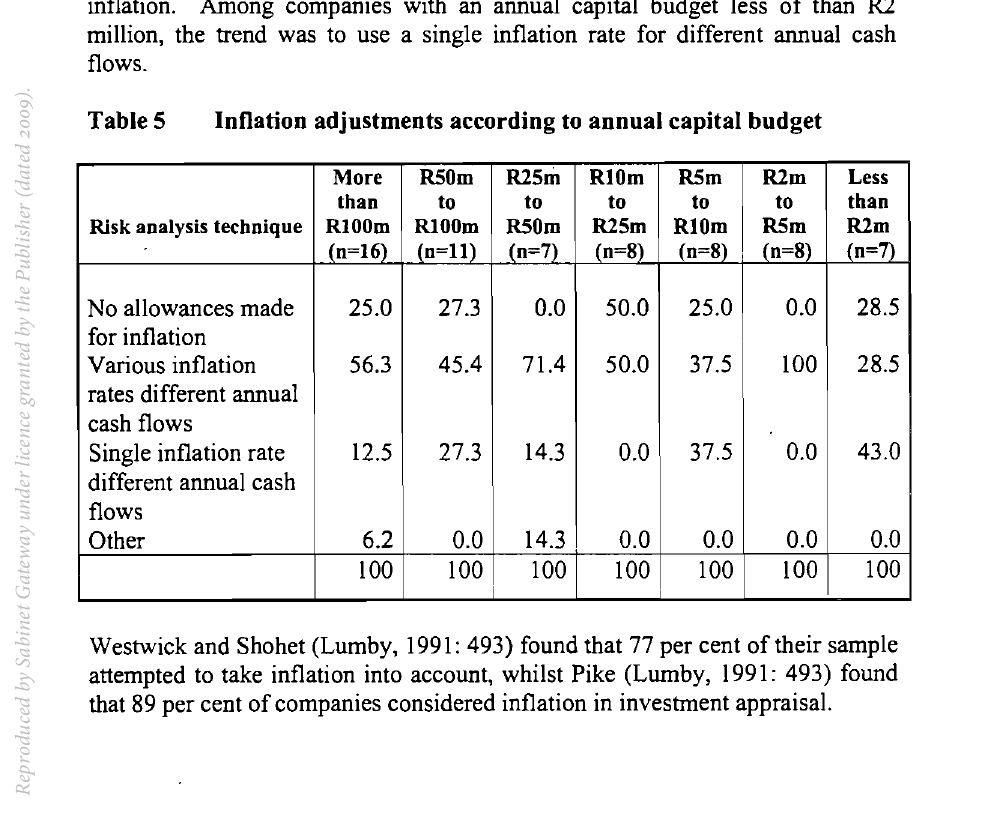
Adjustments made to accommodate fluctuations in the inflation rate Item Percentage No allowances are made for inflation 23.10 Use various inflation rates for different annual cash flows 55.40 Use a single inflation rate for different annual cash flows 18.50 Other 100%